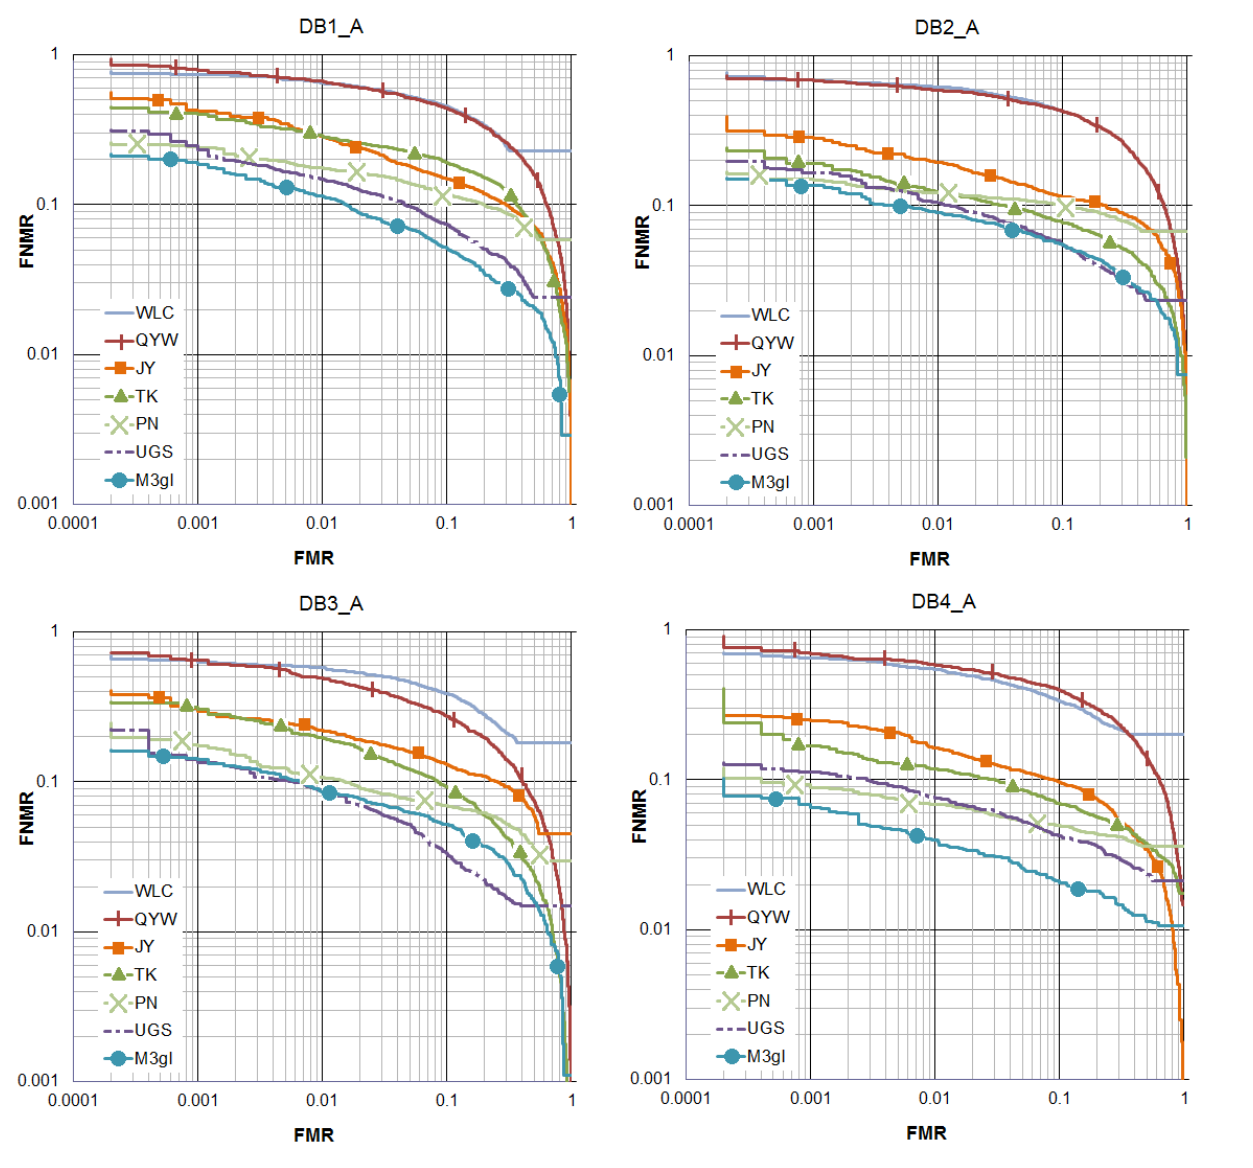
Figure 6. ROC curves with the performance of the compared algorithms in